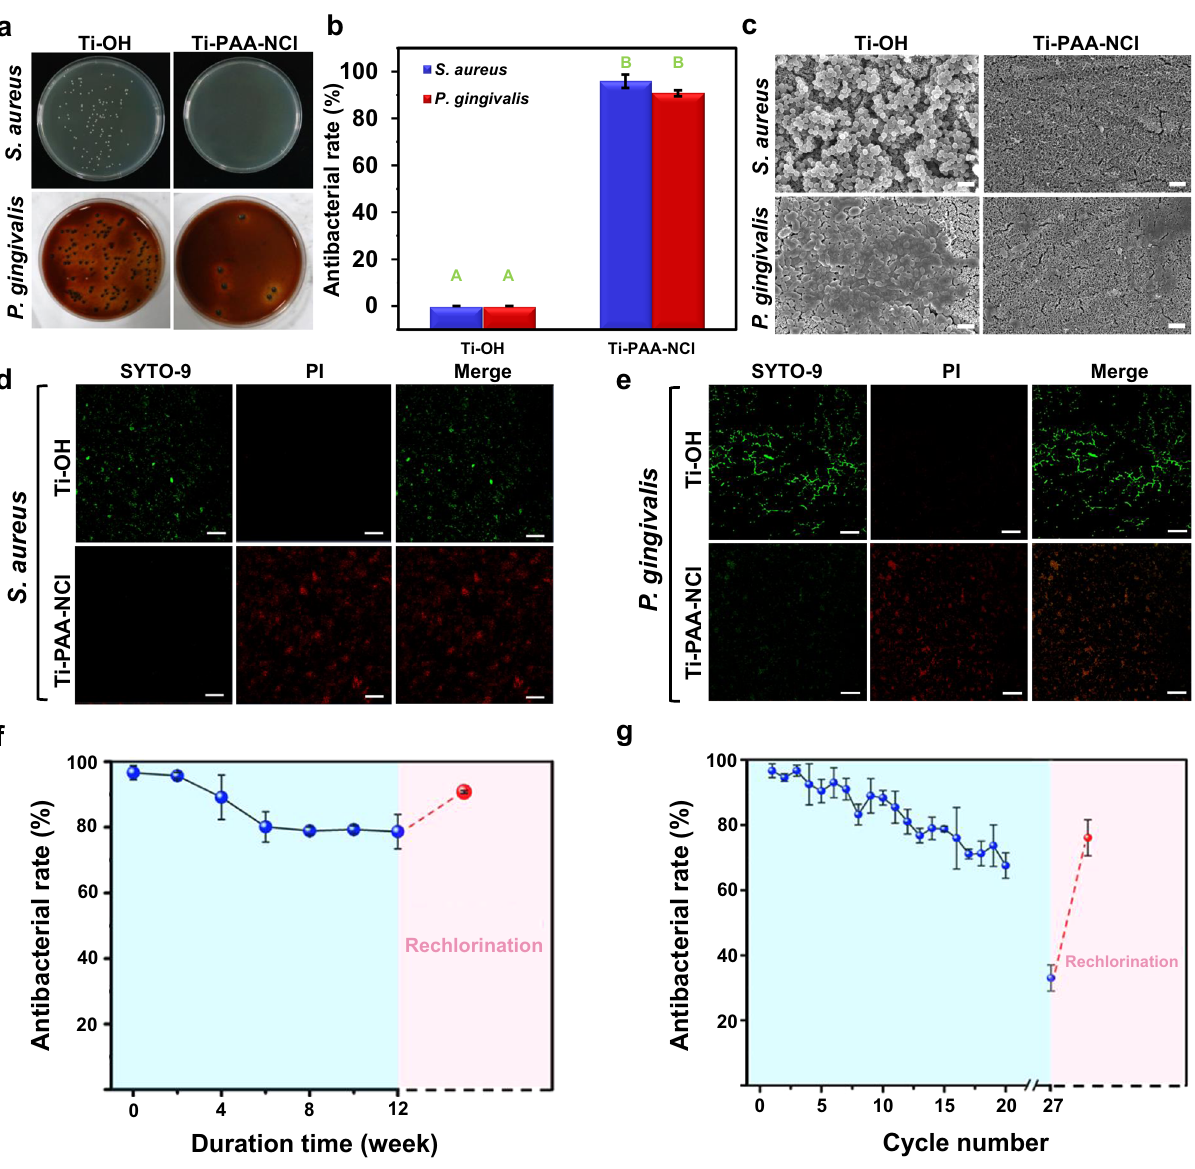
Fig. 3 Antibacterial assessments. a Images of the bacterial colonies formed by S. aureus and P. gingivalis contacted with Ti-OH and Ti-PAA-NCl. b Antibacterial rates against S. aureus and P. gingivalis contacted with Ti-OH and Ti-PAA-NCl. Signi fi cant differences between Ti-OH and Ti-PAA-NCl are marked by different letters ( n = 3; P < 0.0001; Student ’ s t test). c SEM images of S. aureus and P. gingivalis on the surfaces of Ti-OH and Ti-PAA-NCl